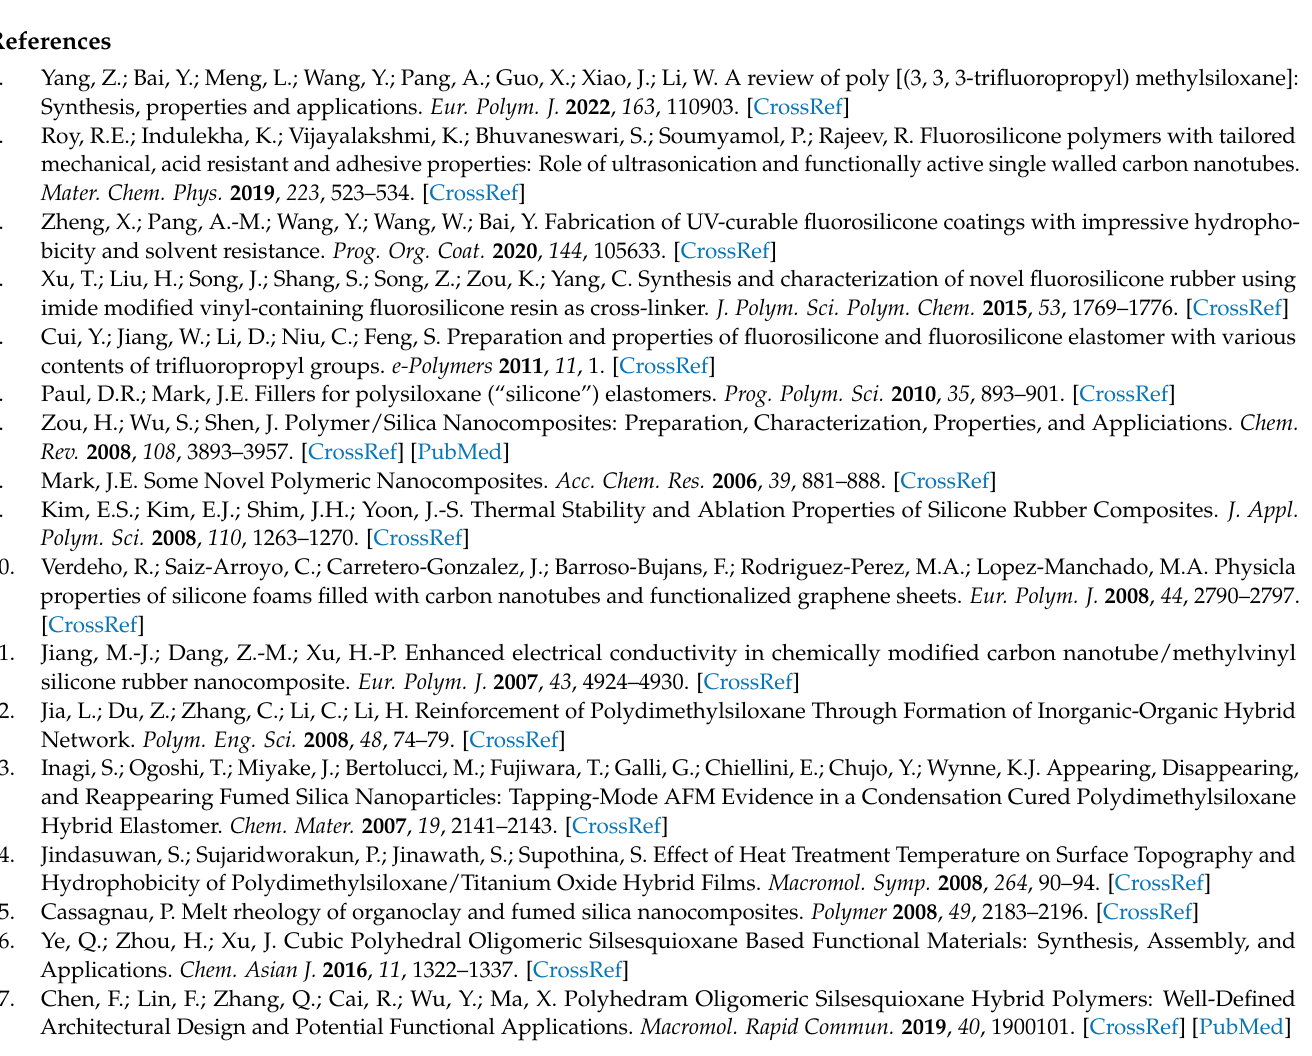
POSS-Vs; Figure S2: (a) FT-IR spectra of synthesized POSS-Vs; (b) 1 H-NMR spectra of synthesized POSS-Vs; Figure S3: SEM micrographs of the POSS-Vs: (a,b) POSS-V8; (c,d) POSS-V6; (e,f) POSS-V4; (g,h) POSS-V0; Figure S4: MALDI-TOF MS spectra of all